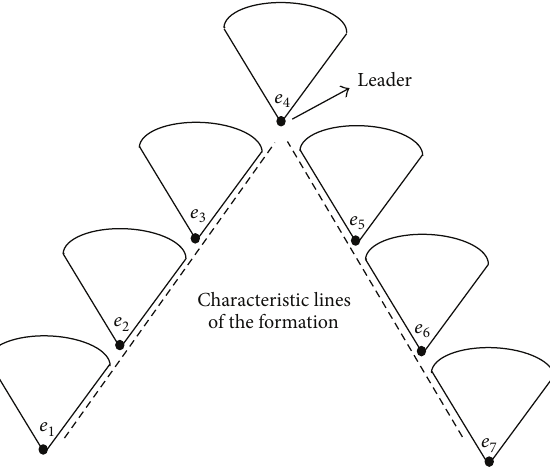
Figure 7: An example of a V-formation at a time-point 𝑡